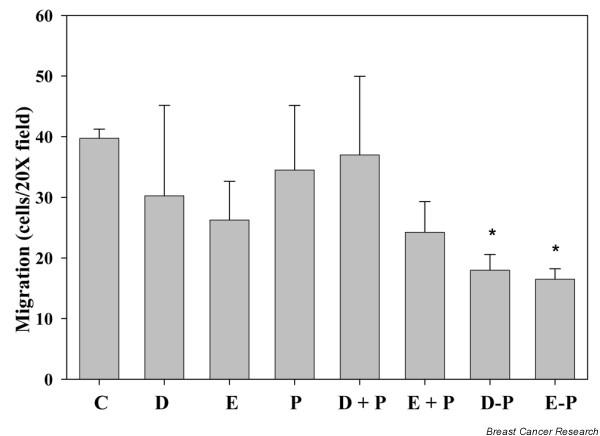
Effect of propofol-docosahexaenoic acid (propofol-DHA) and propofol-eicosapentaenoic acid (propofol-EPA) conjugates on cell migration. MDA-MB-231 cells (104) were incubated for 4 hours with 25 μM DHA (D), 25 μM EPA (E), 25 μM propofol (P), 25 μM each of D+P, 25 μM each of E+P, and 25 μM propofol-DHA (D-P) or 25 μM propofol-EPA (E-P) using transwell plates. The control cells (C) were treated with equal amounts of ethanol. Cells that migrated through the filter were counted under a microscope as described in the text. Results are means ± SEM for four experiments. The results were analyzed by analysis of variance and Dunnett's multiple comparison test to control the Type I experimental wise error. Significant differences from the control (P < 0.05) are indicated with an asterisk.